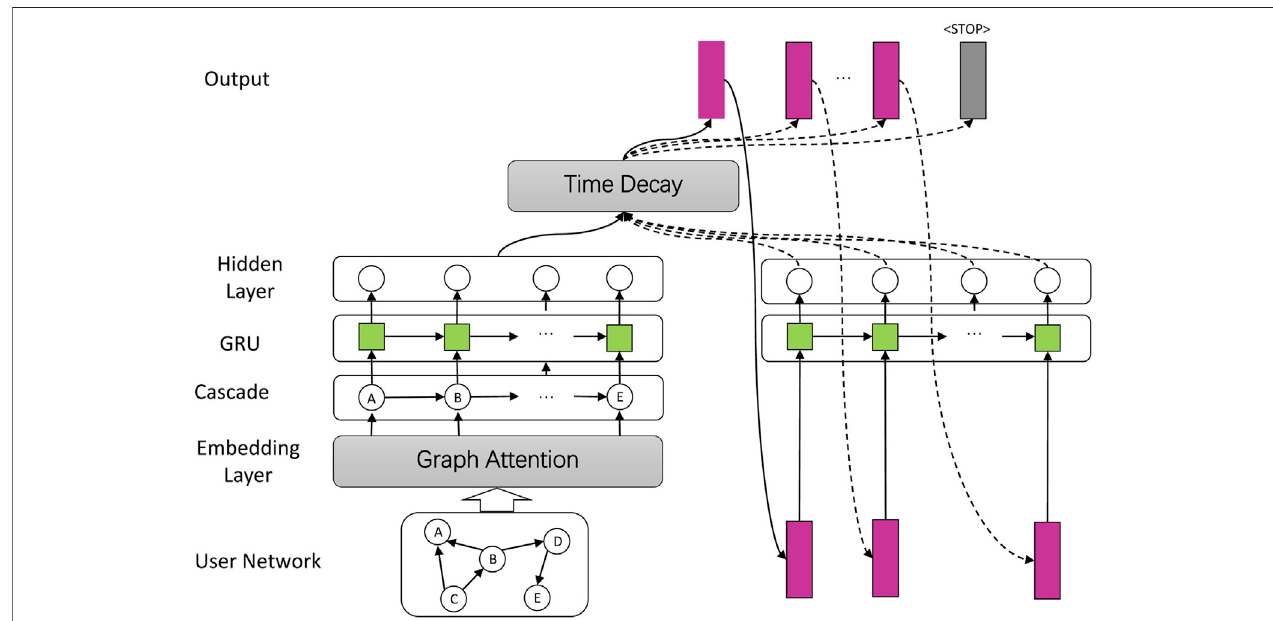
FIGURE2 | Illustration ofproposed model DLIC. Given user networkand aseries of cascades. Ourmodel learns their feature separately and predicts thefollowing infected users.